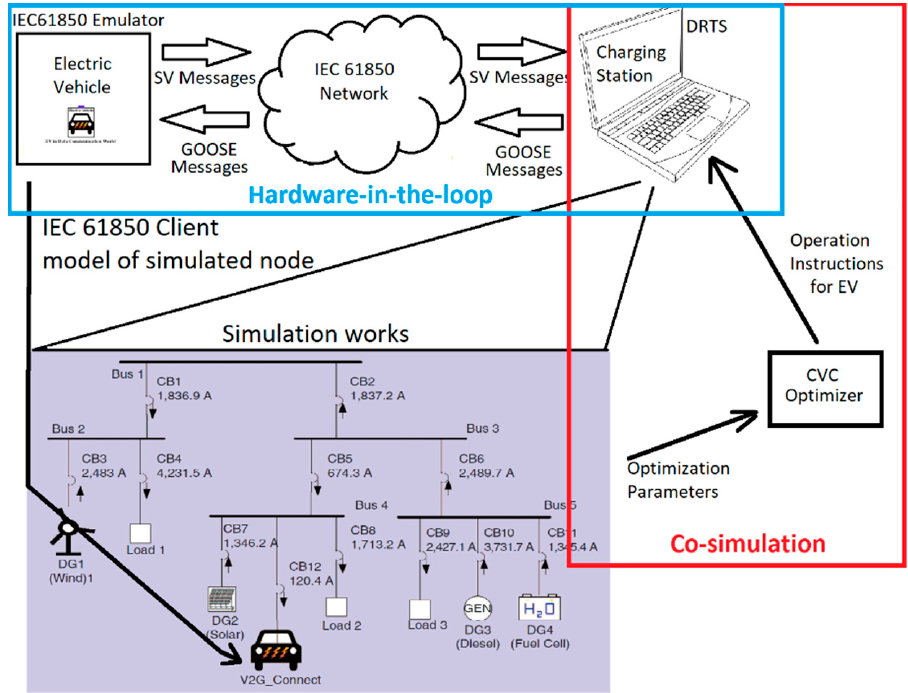
Figure 10. Co ‐ simulation and HIL test set ‐ up for the CVC study. Figure 10. Co-simulation and HIL test set-up for the CVC study. The tested power system was a microgrid with renewable energy penetration, as shown in Figure 11. In addition to renewable-energy-based generators such as PV and fuel cells, battery storage was deployed to mitigate their impacts such as voltage rise during excess generation. For the purposes of this study, battery storage was replaced with a CS where a fleet of EVs was available. It was also possible to simulate cases where the CS was empty. This was achieved by setting the SoC to 0% with no charging activity.